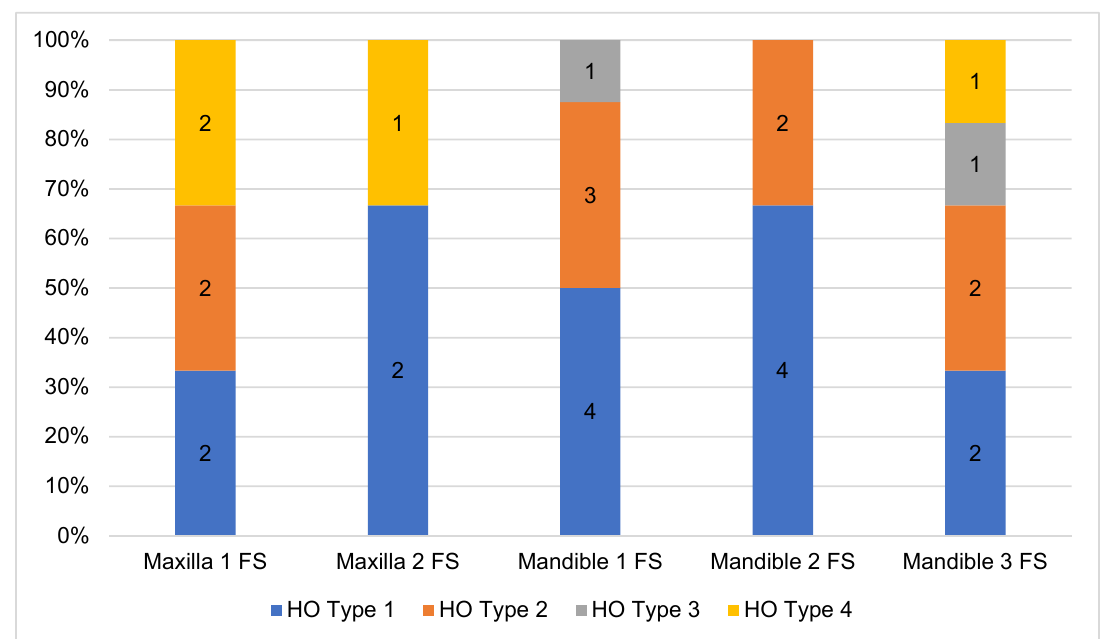
Figure 5. Distribution of HO types according to the number of used fibula segments for jaw reconstruction.